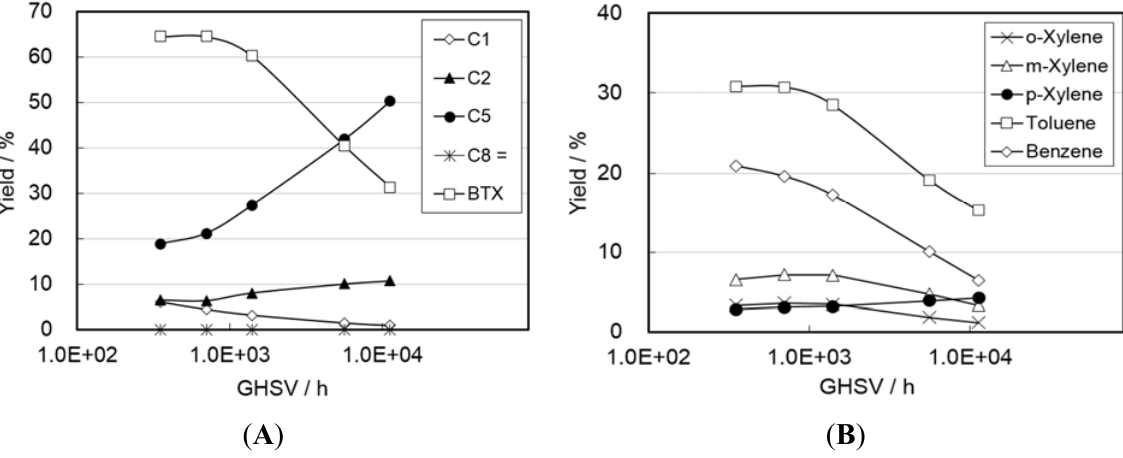
Figure 4. Correlation between space velocity and product distribution on Zn-MFI at 773 K. Panels ( A , B ) summarize the distributions of C 1 –C 8 compounds and aromatics. Reaction conditions: catalyst 0.125–2.00 g; total gas flow rate 20–40 mL·min − 1 ; P 2OcOH 5%; N 2 95%; 1